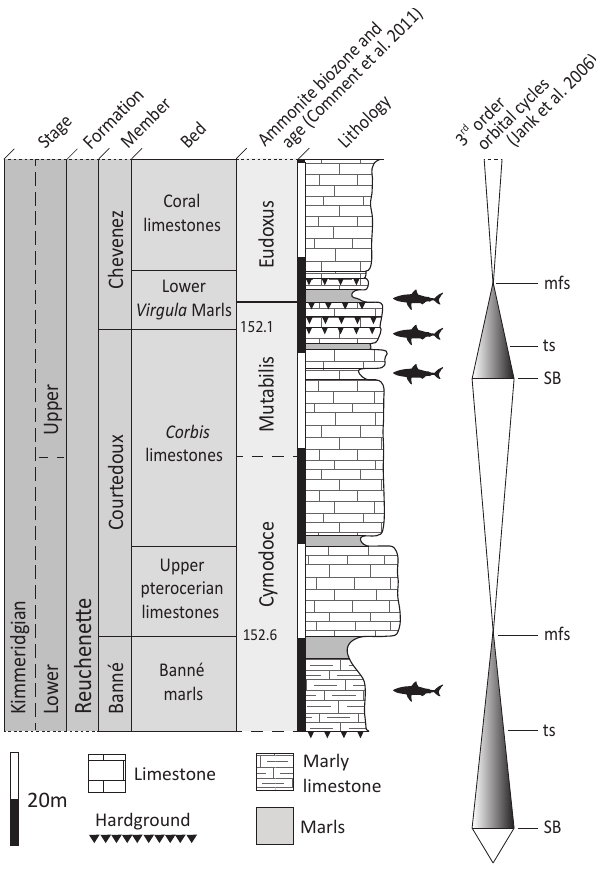
Figure 2. Simplified stratigraphic profile of the Porrentruy area with third order orbital cycles and section yielding the studied chon- drichthyan material. Numbers indicate geological age in millions of years. SB = sequence boundary, ts = transgressive surface, mfs = maximum flooding surface.